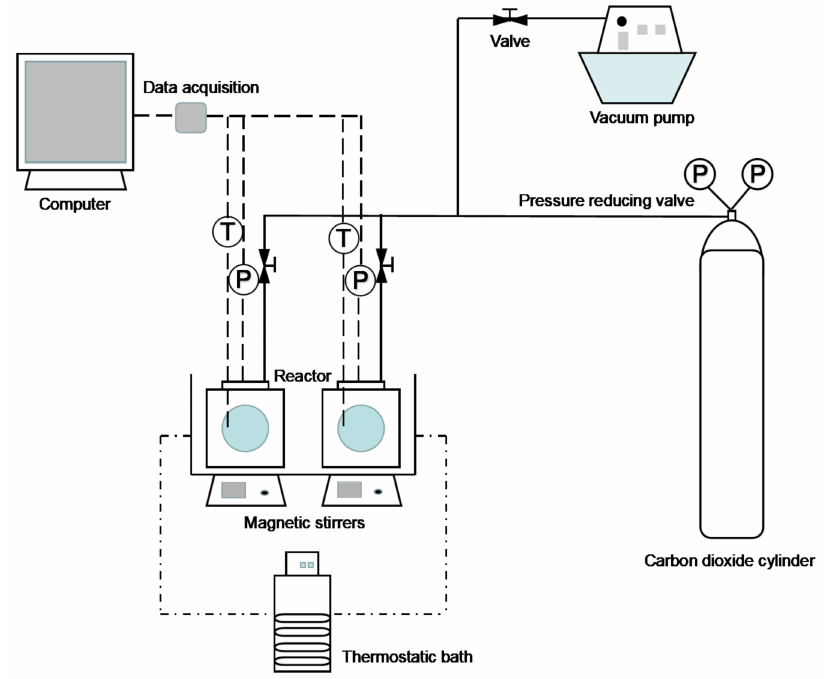
Figure 1. Schematic of the experimental setup.